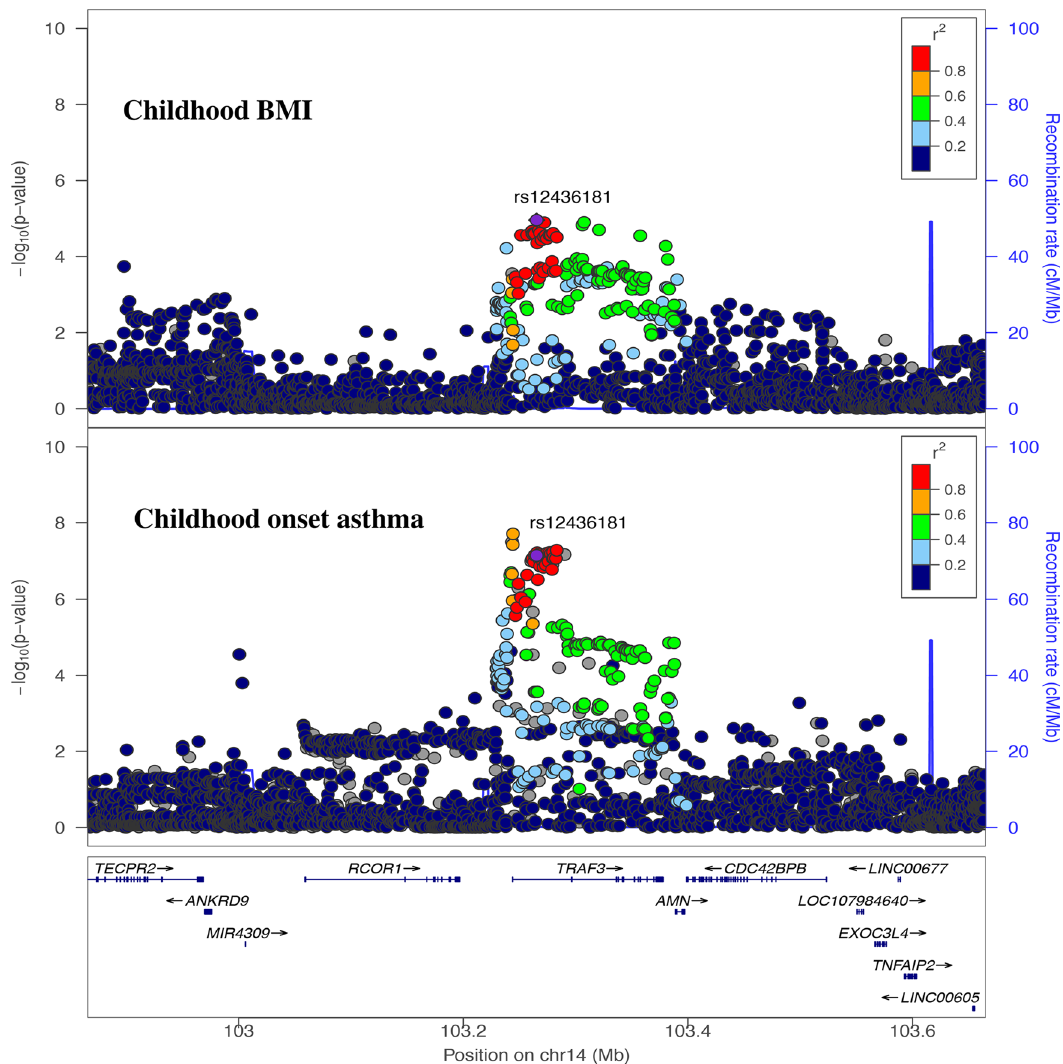
Fig. 4 Bayesian colocalization analysis identi fi es a shared causal variant between childhood BMI and childhood-onset